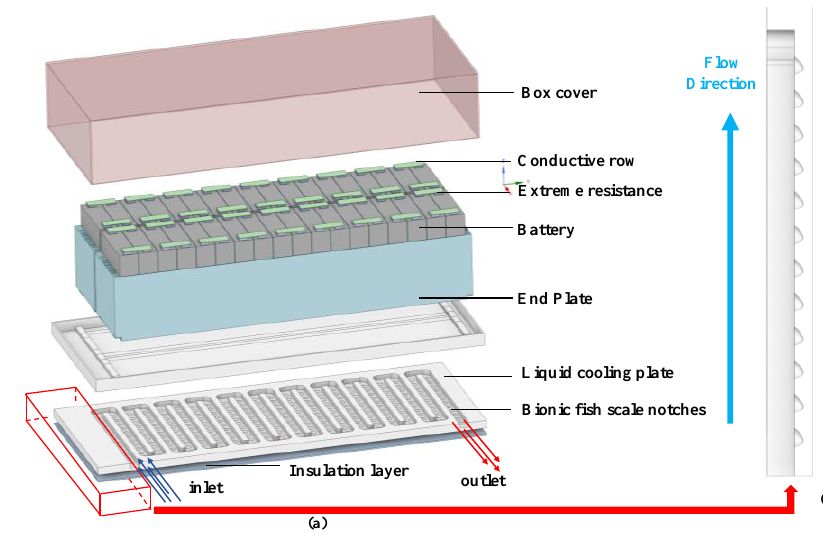
Figure 1. ( a ) Battery pack structure ( b ) Side view of liquid cooling Figure 1 . ( a ) Battery pack structure ( b ) Side view of liquid cooling plate. Table 1 . Battery pack structure parameters.